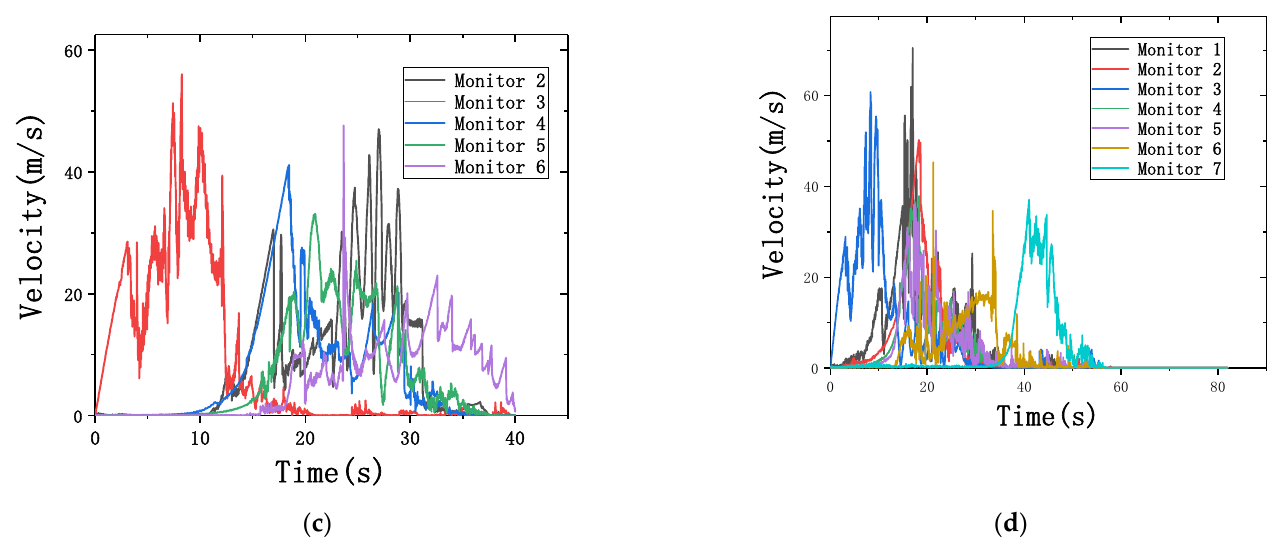
Figure 14. Time history curves of velocity of monitors in the high ‐ steep rock slide process. ( a ) Case 1: EW seismic wave; ( b ) case 2: NS seismic wave; ( c ) case 3: UD seismic wave; and ( d ) case 4: EW_NS_UD seismic wave.